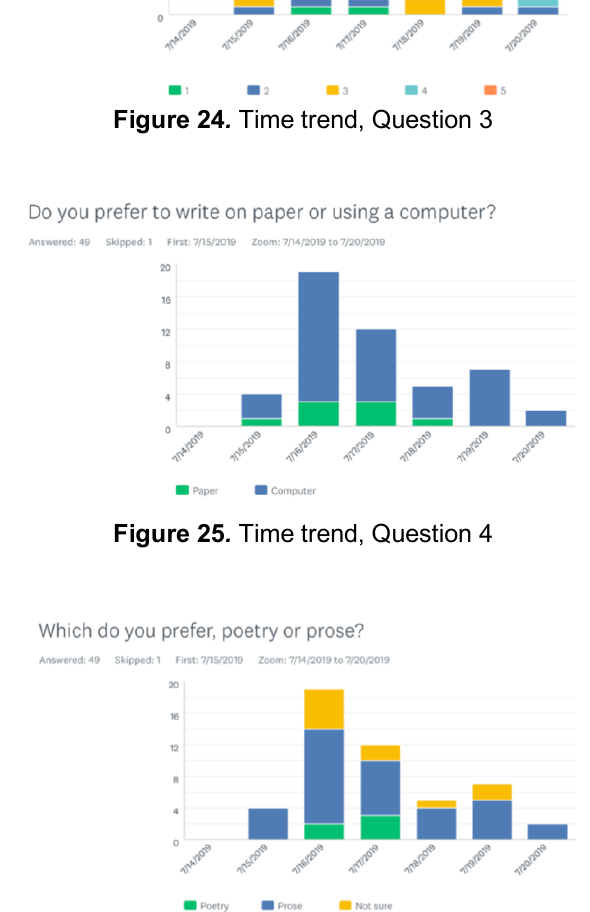
Figure 26 . Time trend, Question